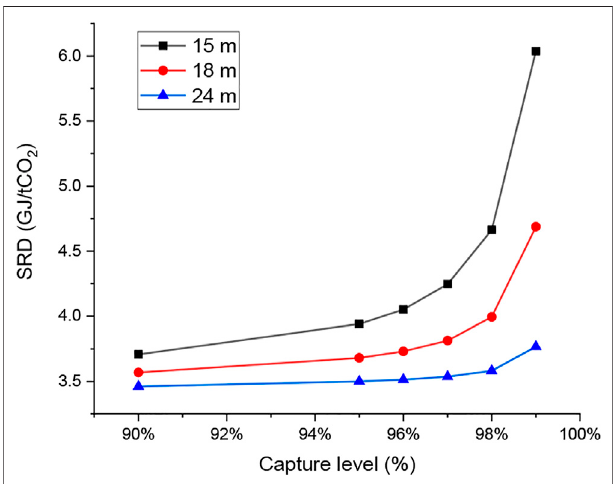
FIGURE 9 | The optimal SRD for different capture levels and absorber packing heights.